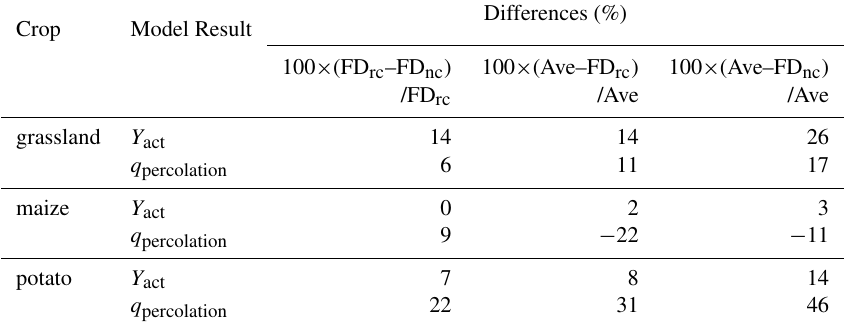
Table 5. Results of soil–crop experiments: differences (%) between results from three different hydrological conditions: FDnc (free drainage with no recirculation), FDrc (free drainage with recirculation) and Ave (average drainage